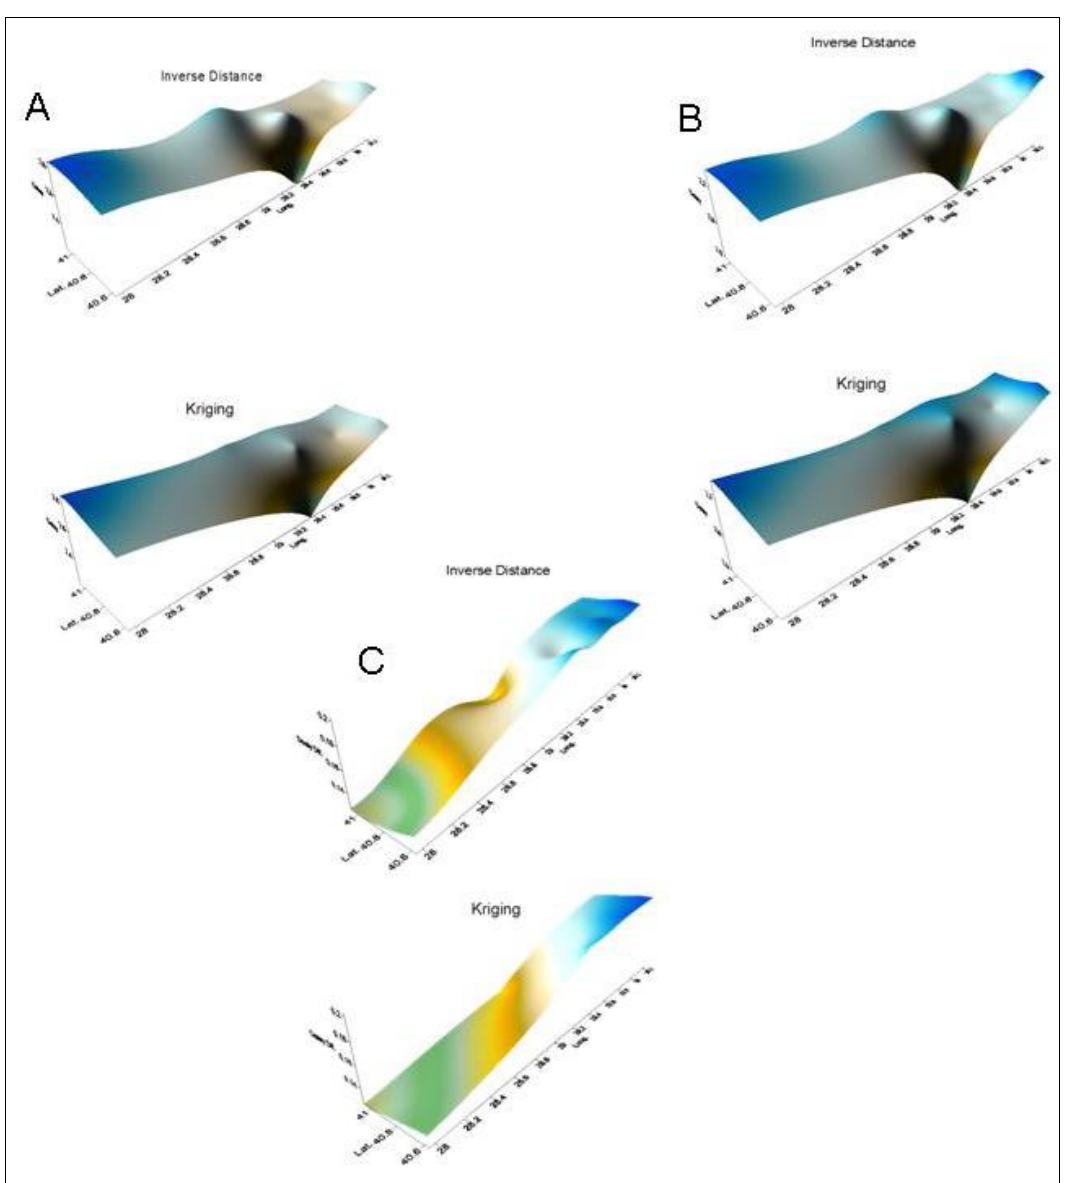
Figure 3. Troposperic Delays for ERS1/2 images (imaging time 16-17 September 1999 20:14). A) 16 September 1999 20:12 Tropospheric delays B) 17September 1999 20:12 Tropospheric delays C) 17-16 September 1999 20:12 delay